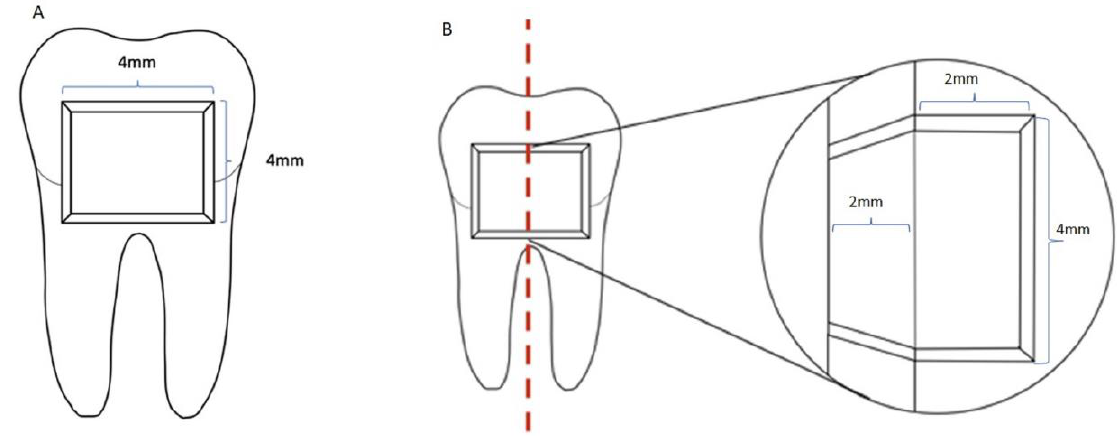
Figure 1. Cavity design ( A ); longitudinal view of the cavities after molar sectioning ( B ). Table 2. Study subgroups accordingly dentin conditioning procedures and SDF/KI application ( n = 10 cavities) in each